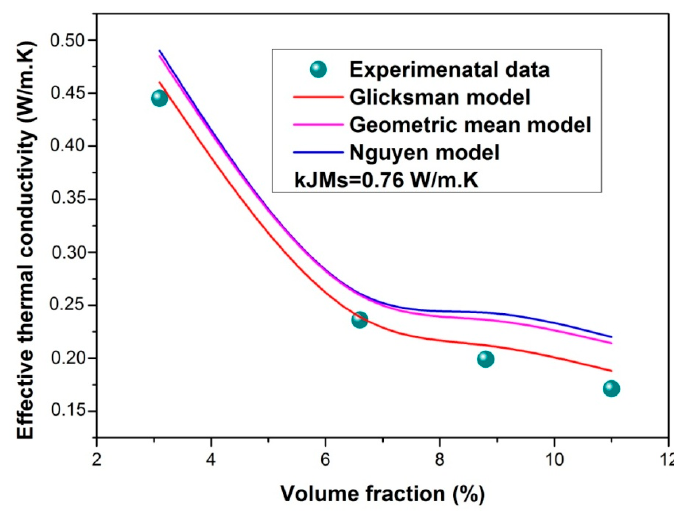
Figure 7. Experimental results compared with theoretical models calculated with k JMs = 0.76 W/m·K.